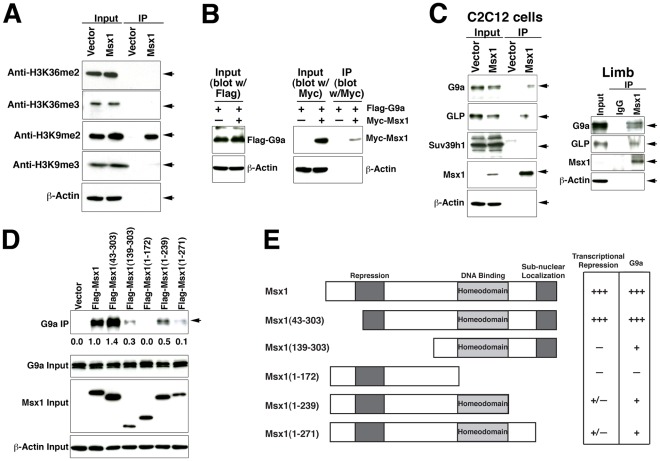
Msx1 binds to G9a/GLP via the homeodomain and the C-terminal region.(A) Co-immunoprecipitation assays were done using C2C12 cell protein extracts expressing Flag-Msx1 and immunoprecipitated with anti-Flag followed by immunoblotting for the indicated histone marks. (B) 293T cells were transfected with the indicated expression plasmids. Proteins were immunoprecipitated with Flag antibodies and immunoblotted with anti-Flag or Anti-Myc, as indicated. (C) (Left) C2C12 cell protein extracts expressing Flag-Msx1 were immunoprecipitated with anti-Flag following by immunoblotting with antibodies to detect the indicated proteins. (Right) Limb extracts (11.5 dpc) expressing endogenous Msx1 were immunoprecipitated with anti-Msx1 antibody (4F11) following by immunoblotting with antibodies to detect the indicated proteins. (D) Truncated Msx1 proteins expressed in 293T cells were immunopurified with anti-Flag followed by immunoblotting to detect G9a. Shown is the quantitative analyses of G9a, normalize to G9a input and Msx1 input. In each immunoprecipitation assays, 1 mg of protein was used and input was 1% of the total protein. (E) Schematic representation of Msx1 and truncated derivatives showing a summary of data.